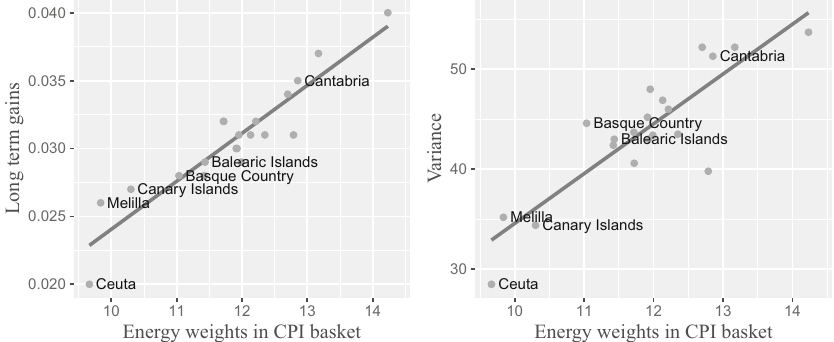
Fig. 7 Relationship between Energy weights in CPI basket by Spanish regions (2019) and the long-term gains (left) and the percentage of variance that can be attributed to oil price shocks